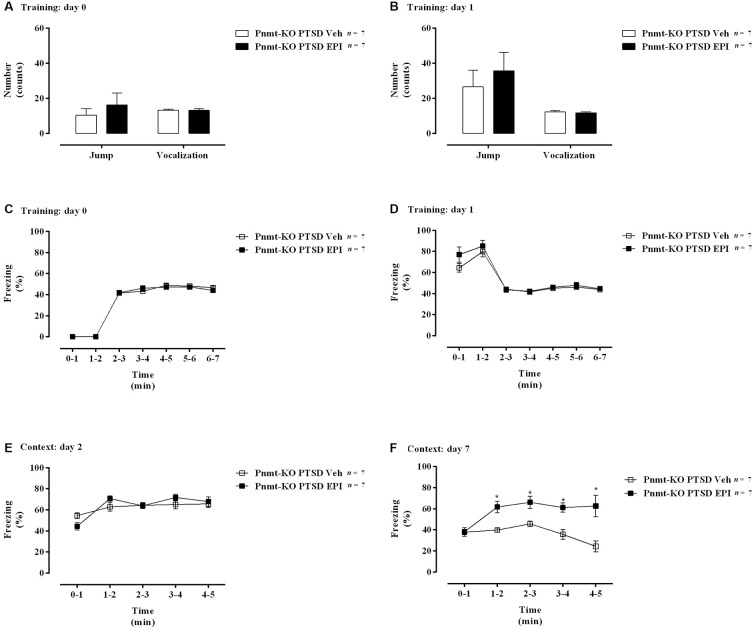
(A,B) Shock responsivity on training sessions and (C–F) freezing behavior during the induction of PTSD. Freezing on (C) day 0, (D) day 1, (E) day 2, and (F) day 7 in phenylethanolamine-N-methyltransferase-knockout (Pnmt-KO) mice in the PTSD-induction group administered with epinephrine (EPI) or vehicle (Veh). Values are means ± SEM of 7 mice per group. Pnmt KO PTSD EPI, Pnmt-KO mice in the PTSD-induction group administered with epinephrine. Pnmt-KO PTSD Veh, Pnmt-KO mice in the PTSD-induction group administered with the vehicle. *Significantly different from correspondent values in Pnmt-KO mice in the PTSD-induction group administered with vehicle (p < 0.05).